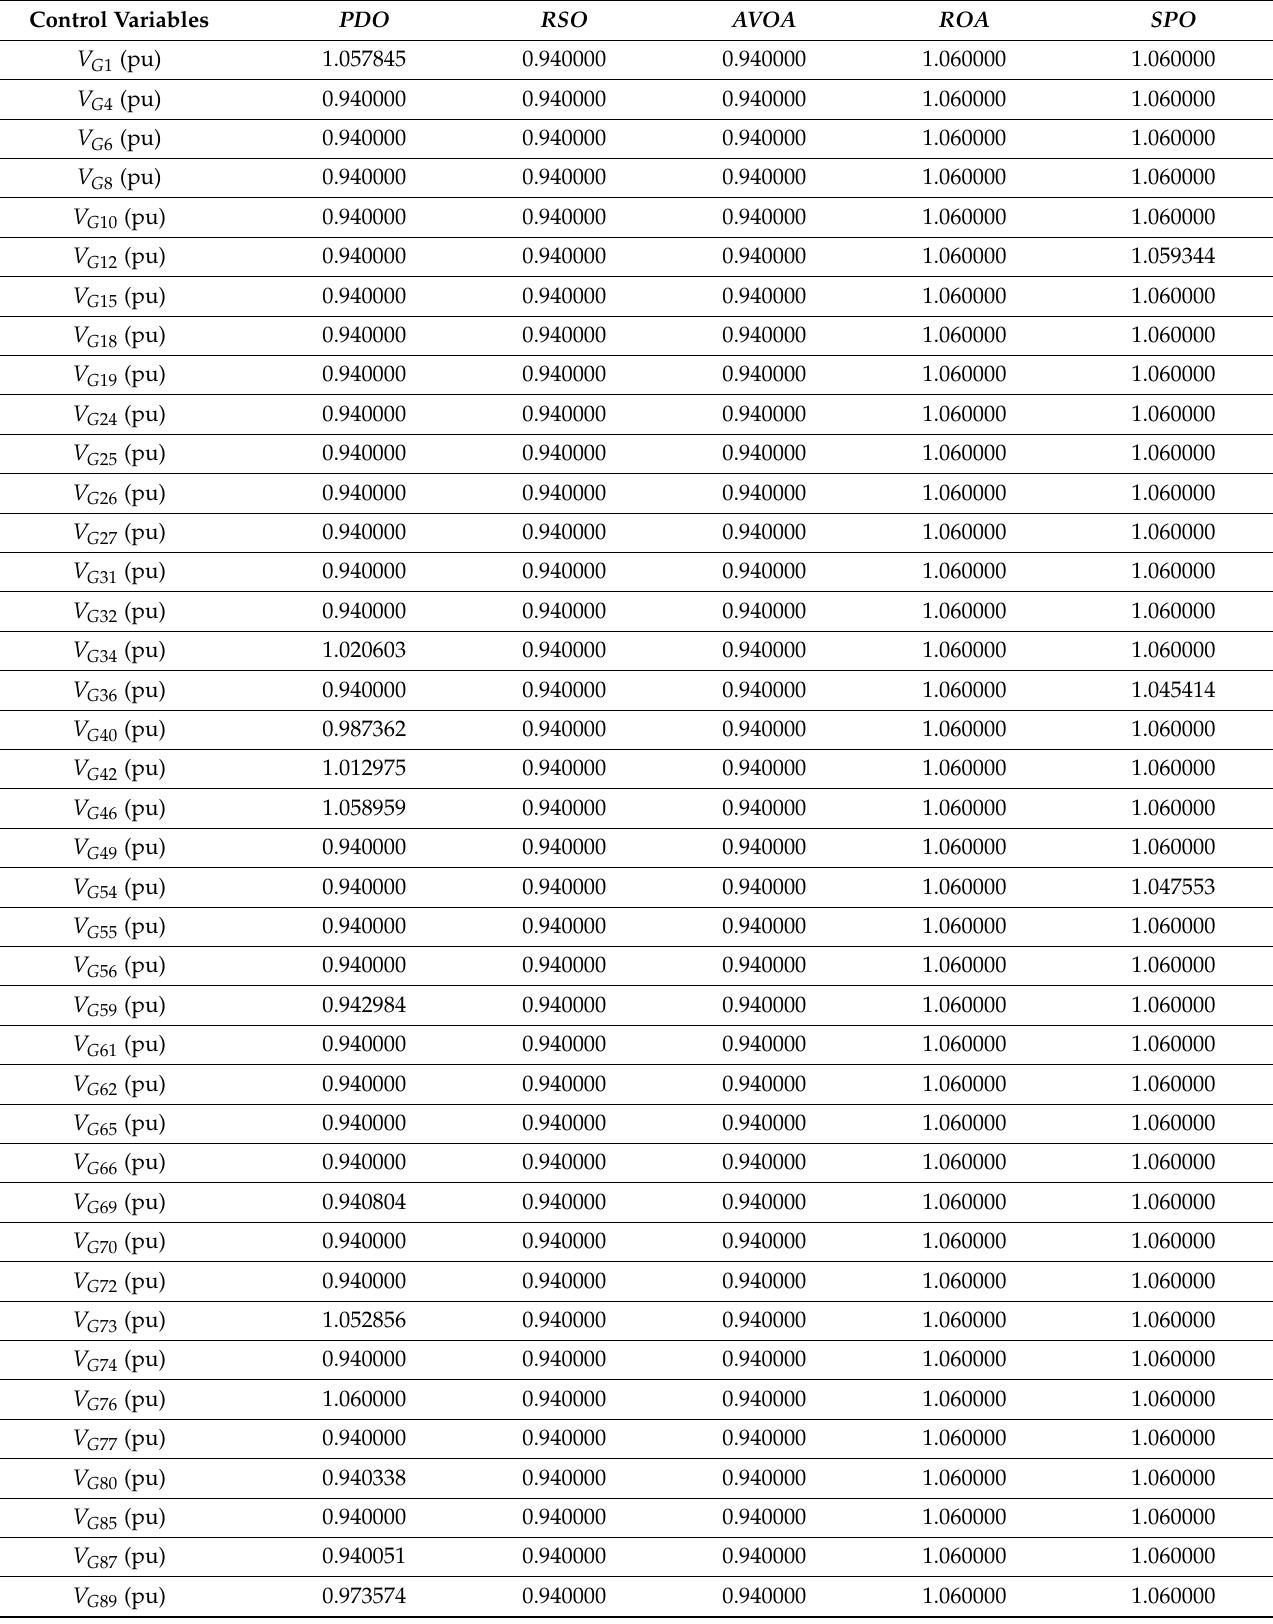
Table 24. Minimization of multi-objective functions (voltage-level deviation, operational cost, and transmission power loss) with discrete control variable settings in IEEE-118